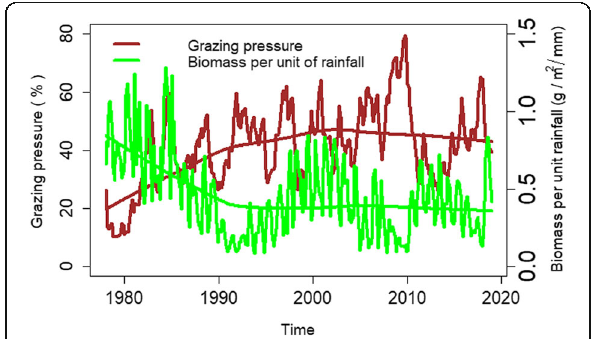
Fig. 9 Decline in the resilience of the plant community measured by the diminished production per unit of rainfall due to intensified grazing pressure.